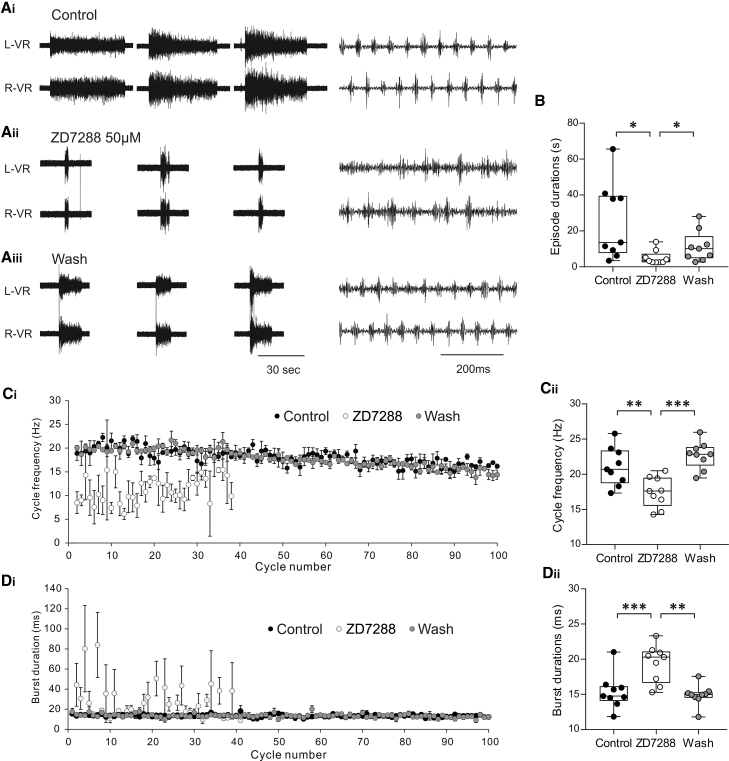
The Effects of ZD7288 on Xenopus Swim Network Output(A) Two simultaneously recorded raw ventral root traces on the left and right sides showing evoked swim episodes in control (Ai), in the presence of the Ih current blocker ZD7288 (50 μM; Aii), and after washout (Aiii). The right side panels show an expansion of fictive swimming activity.(B) ZD7288 (10–50 μM) significantly shortened episode duration (p = 0.026), and the effect was reversed following washout of ZD7288 (n = 9 complete experiments; p = 0.027; median with 50% IQR displayed as box-and-whisker plots).(C) Time plot showing (Ci) mean swim cycle frequency across 3 evoked episodes in control, ZD7288, and after washout. Note that the swim frequency is lower and more variable. (Cii) ZD7288 (50 μM) caused a significant decrease in cycle frequency (p = 0.0008; n = 9; median with 50% IQR displayed as box-and-whisker plots).(D) Time plot showing (Di) mean burst durations across 3 evoked episodes in control, ZD7288, and following washout. (Dii) ZD7288 (50 μM) caused a significant increase in burst duration (p = 0.0018; n = 9; median with 50% IQR displayed as box-and-whisker plots).∗p < 0.05; ∗∗p < 0.01; ∗∗∗p < 0.001. See also Figure S3.